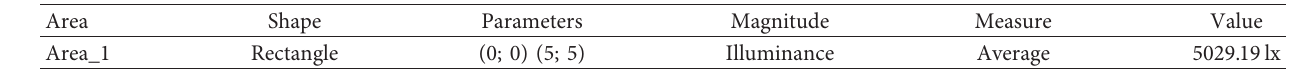
Figure 9: Schematic diagram of geometric bevel angle 2 and optical simulation results. Table 1: Optical analog measurement value of geometric bevel angle